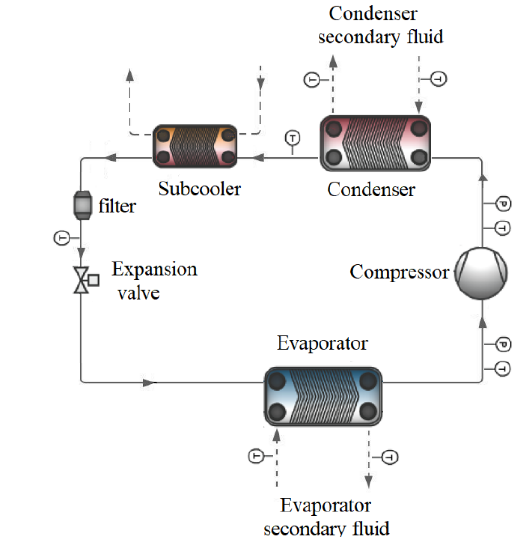
Figure 3. A simplified drawing of the cooling system.